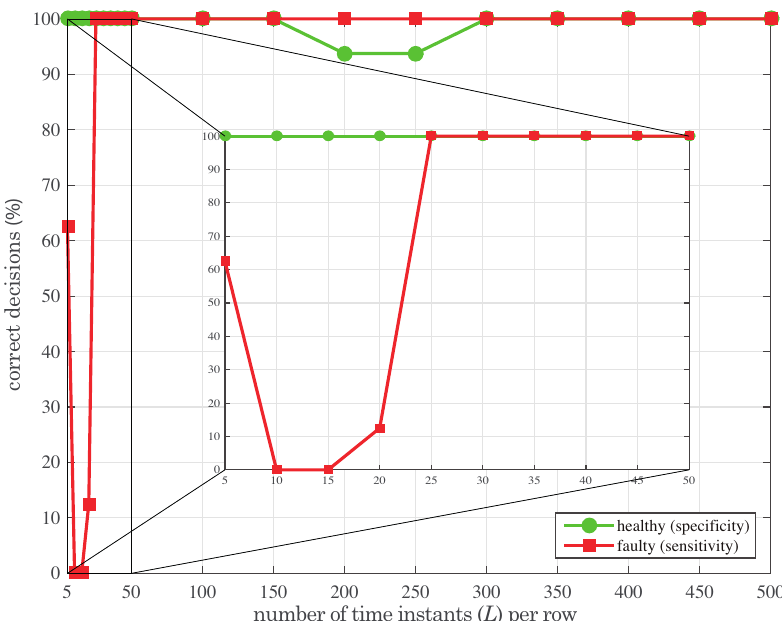
Figure 7. Specificity ( green ) and sensitivity ( red ) of the test as a function of the number of time instants per row ( L ) when the first score is used.